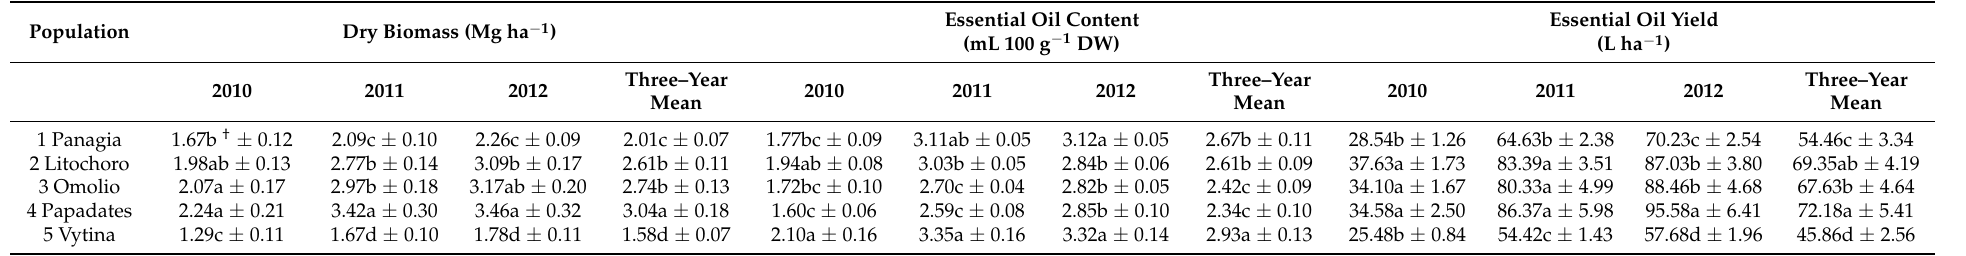
Table 4. Mean dry biomass production (Mg ha − 1 ), essential oil content (mL 100 g − 1 DW) and essential oil yield (L ha − 1 ) of each of the five Greek oregano populations, averaged for the four nitrogen fertilization levels (control, N1, N2, N3, that correspond to 0, 40, 80 and 120 kg N ha − 1 , respectively), for each cultivation year and averaged for the three-year period.